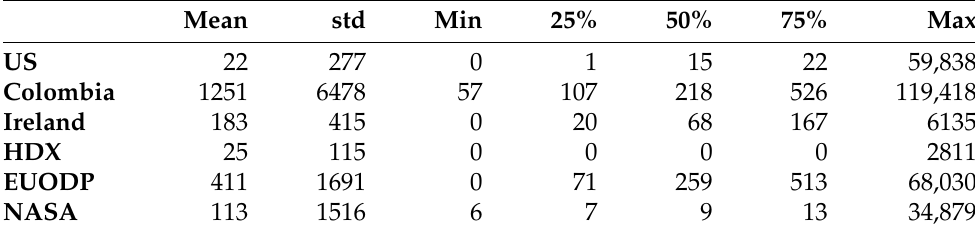
Table 2. Descriptive Usage Statistics: number of Views (up to December 2019).